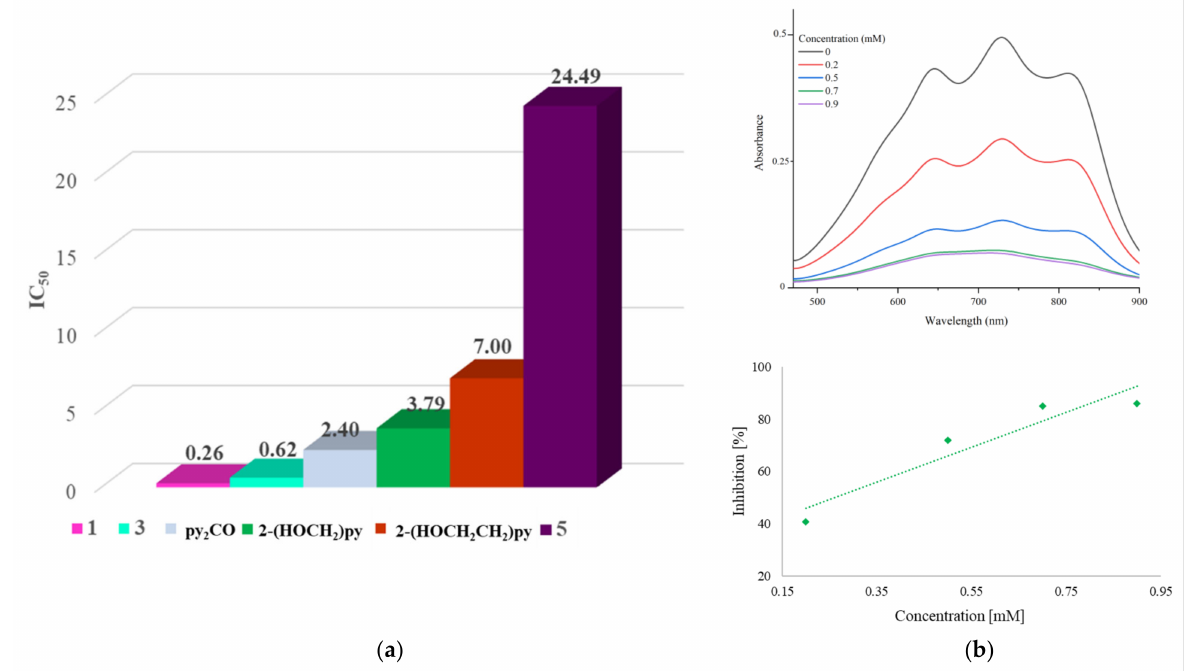
Figure 10. ( a ) ABTS radical scavenging potential of the selected complexes and free ligands, ( b ) example absorption spectra of ABTS • + with various concentrations of complex 1 and plot of antioxidant properties (% inhibition) of ABTS + .